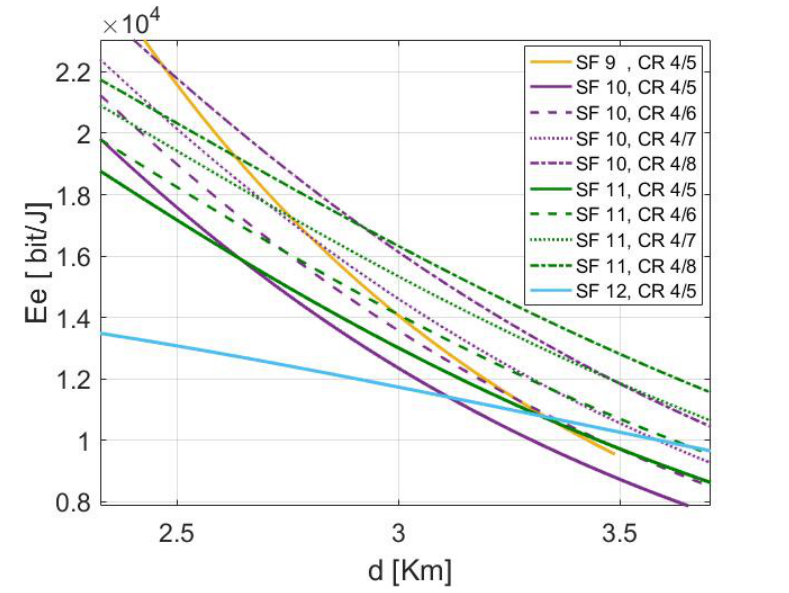
Figure 11. Energy efficiency performance comparison between of different possible transmission settings at the distance d = 3 km.